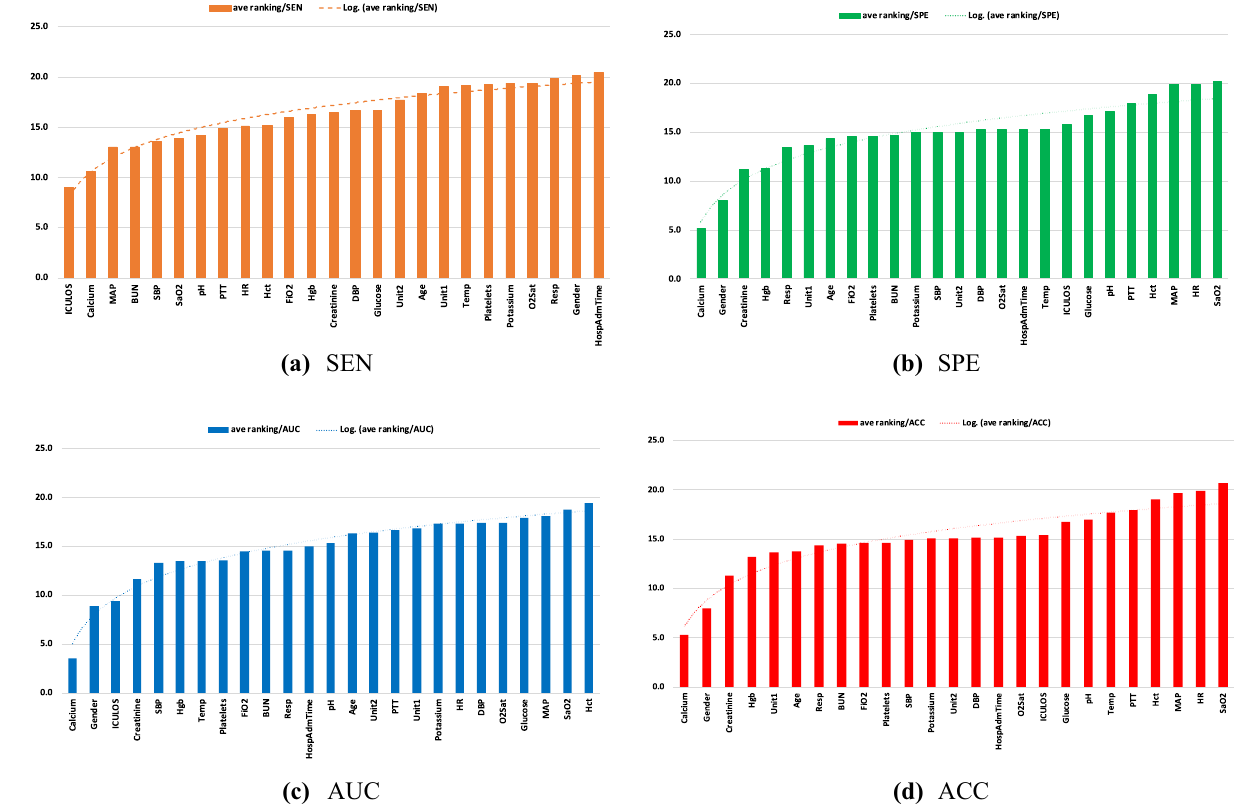
Figure 8. Overall feature importance ranking for BiLSTM predictions under various measures of predictive